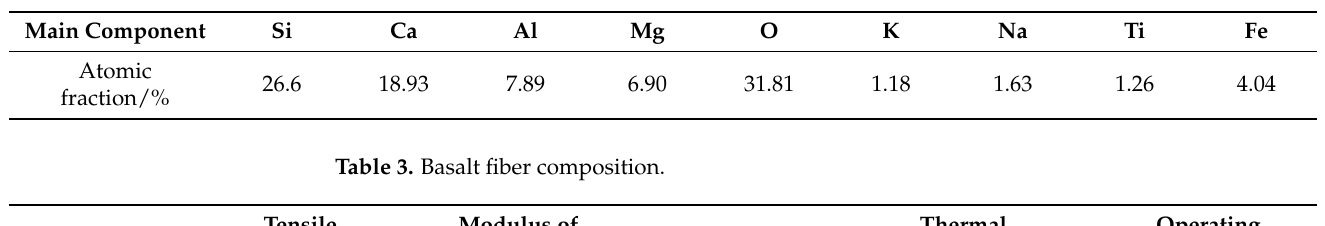
Figure 3. Grain size distribution curve.